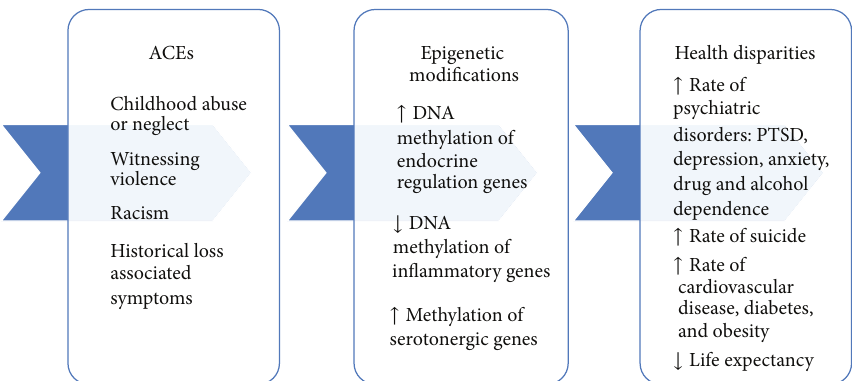
Figure 1: The mediating relationship of epigenetics on the risk for health disparities in Native Americans with childhood adversity.